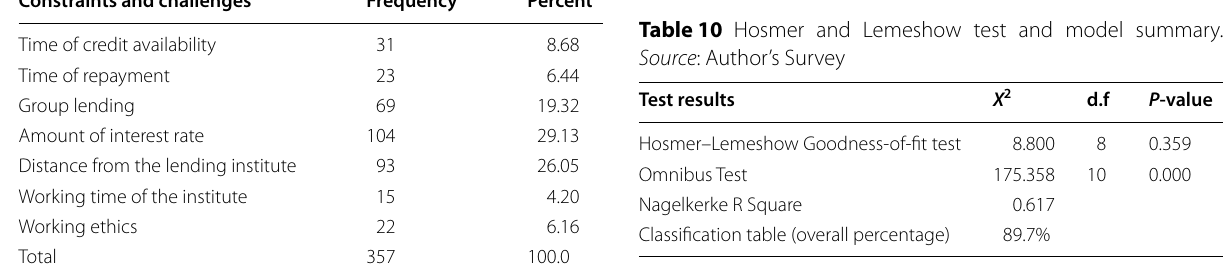
Table 10 Hosmer and Lemeshow test and model summary.